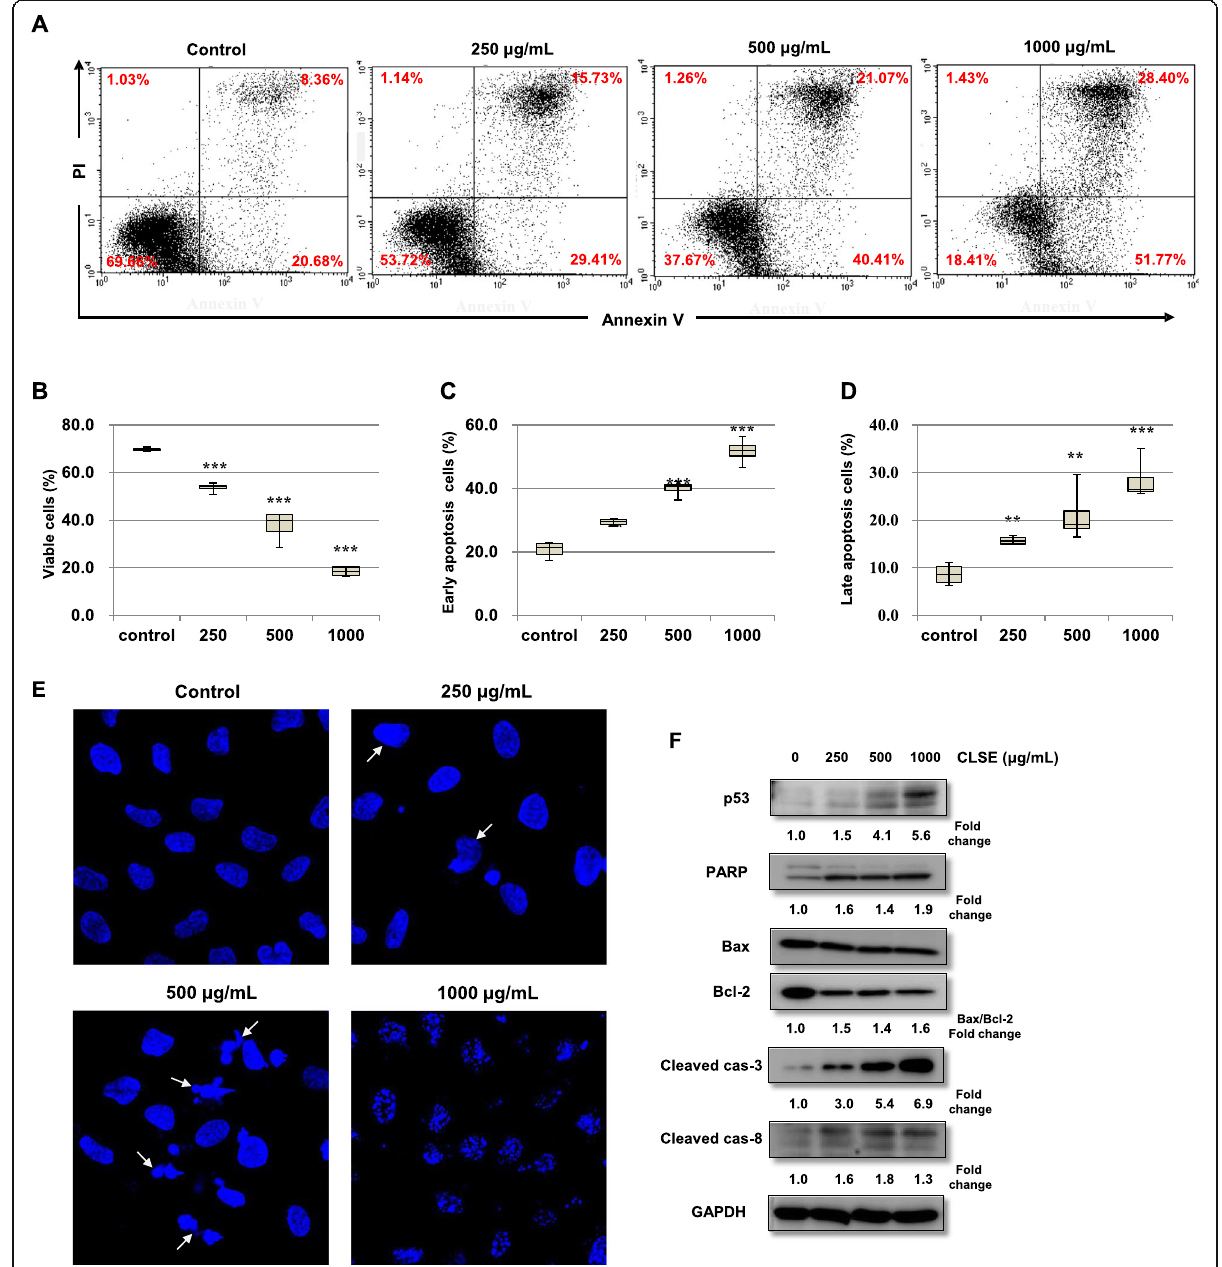
Fig. 4 Effects of Coix lacryma-jobi sprout extract (CLSE) on HeLa cell apoptosis. a – d HeLa cells were stained with FITC-annexin V/propidium iodide (PI) after treatment with various concentrations of CLSE (0 – 1000 μ g/mL) for 72 h, and cell populations and the extent of apoptosis were measured by flow-cytometric analysis. a Representative cell apoptosis dot plots for FITC-annexin V/PI staining in CLSE-treated cells. b-d Quantification of viable cells (FITC-annexin V − /PI − ), early-apoptotic cells (FITC-annexin V + /PI − ), and late-apoptotic cells (FITC-annexin V + /PI + ) using four independent cell populations. e HeLa cells were stained with DAPI (1 μ g/mL) after treatment with CLSE (1 – 1000 μ g/mL) for 48 h and observed under a confocal microscope. Arrow, apoptotic cells (magnification: × 400). f HeLa cells were treated with CLSE (1 – 1000 μ g/mL) for 72 h, and apoptosis- related proteins (p53, PARP, Bax, Bcl-2, cleaved caspase-3, and cleaved caspase-8) were examined using western blot analysis. ** p < 0.01 and *** p < 0.001 versus control group. All data values are expressed as the mean ± standard deviation (n =